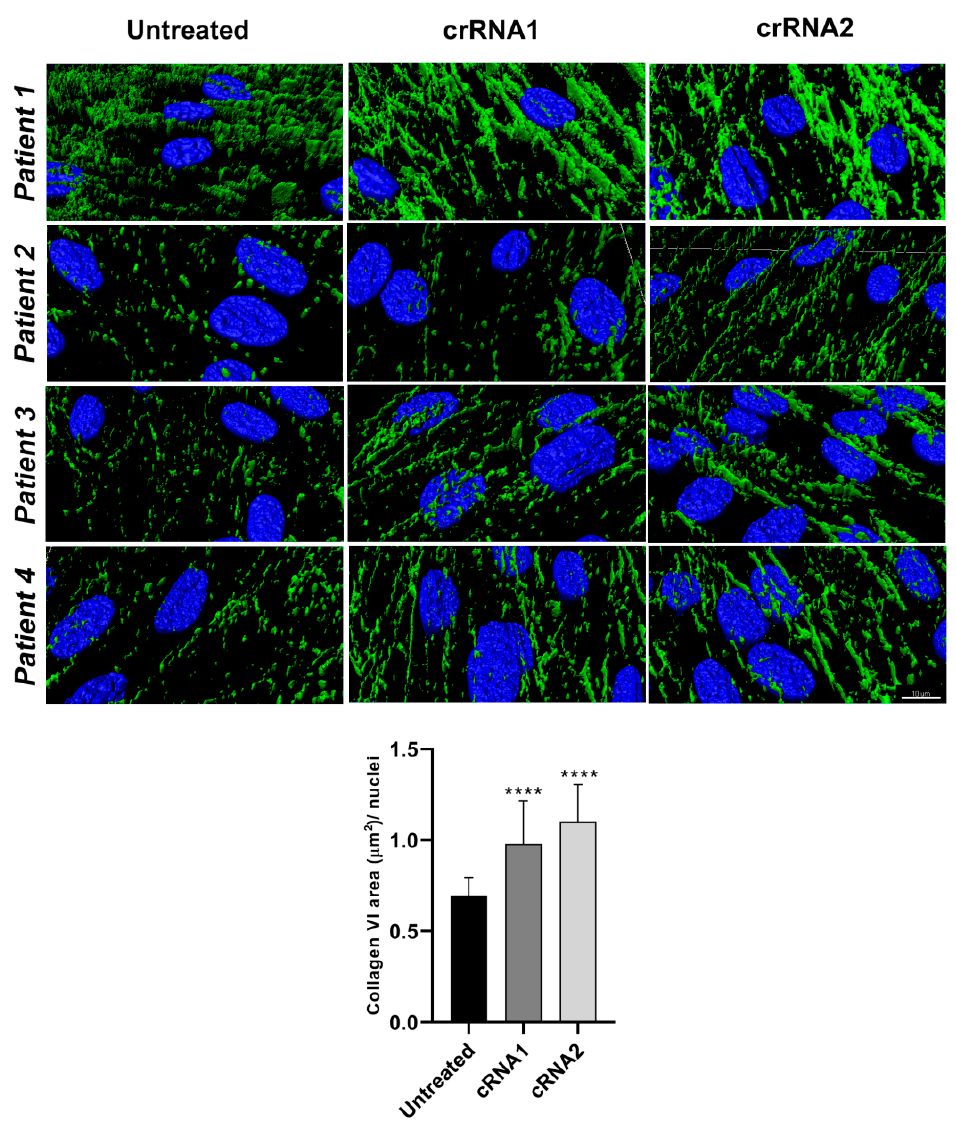
Figure 6. High-resolution 3D rendering images of the collagen VI extracellular matrix before and after editing. Representative images of fibroblasts from four individuals (blue = nuclei, green = collagen VI matrix) before and after treatment with cRNA1 and cRNA2, showing the fragmentation of collagen VI fibrils in untreated cells and their recovery after editing. Images of the collagen VI matrix (green) show few and very thin fibers (or spots/globular aggregates) in the untreated fibroblasts. An interconnected network of collagen VI was observed after treatment. Scale bar = 10 µ m. The lower graph corresponds to the mean ± SD of the quantification of the area of collagen VI in the ECM of unedited and edited fibroblasts of individuals 1–4 with crRNA1 and crRNA2. Data were analyzed by the Wilcoxon-paired test (**** p <